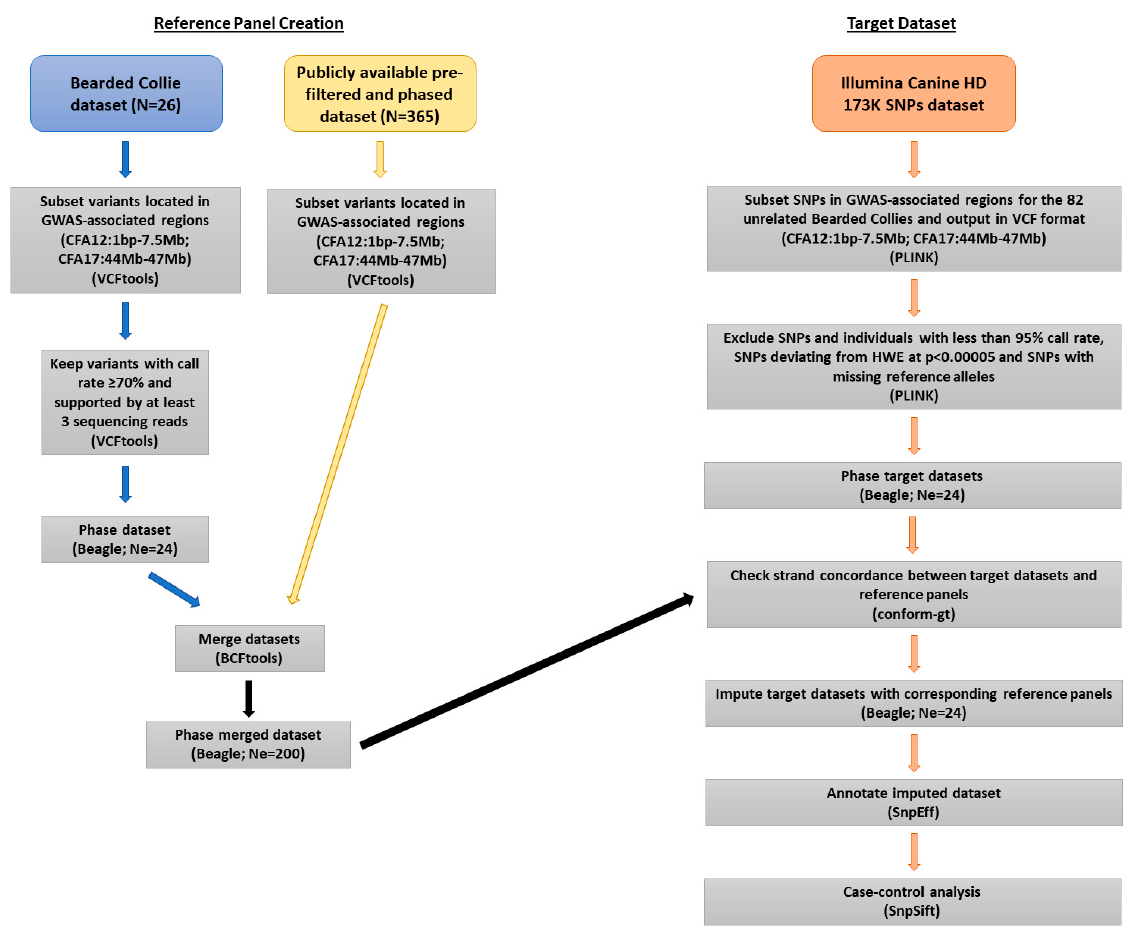
Figure 1 . Flowchart illustrating dataset processing for imputation. Software and relevant parameters used are indicated at each step. The publicly available dataset required no additional filtering and phasing prior to merging. CFA, canine chromosome; N, number of individuals; Ne, effective population size; SNP, single nucleotide polymorphism; HWE, Hardy–Weinberg equilibrium; bp, base pairs; Mb, megabases.